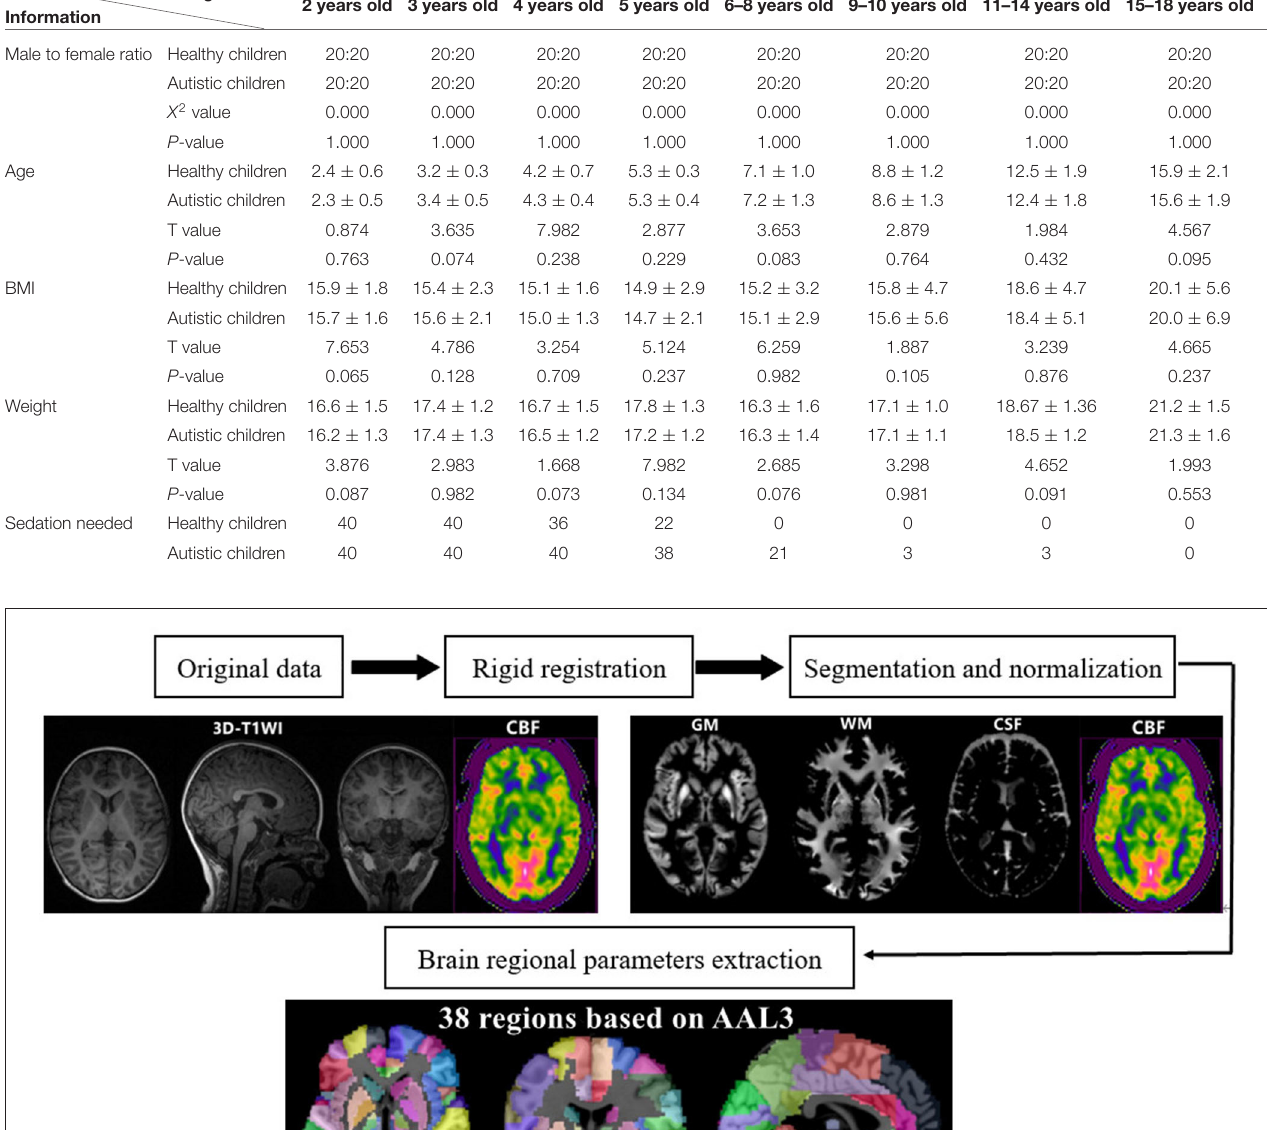
TABLE 1 | Patient information. Information